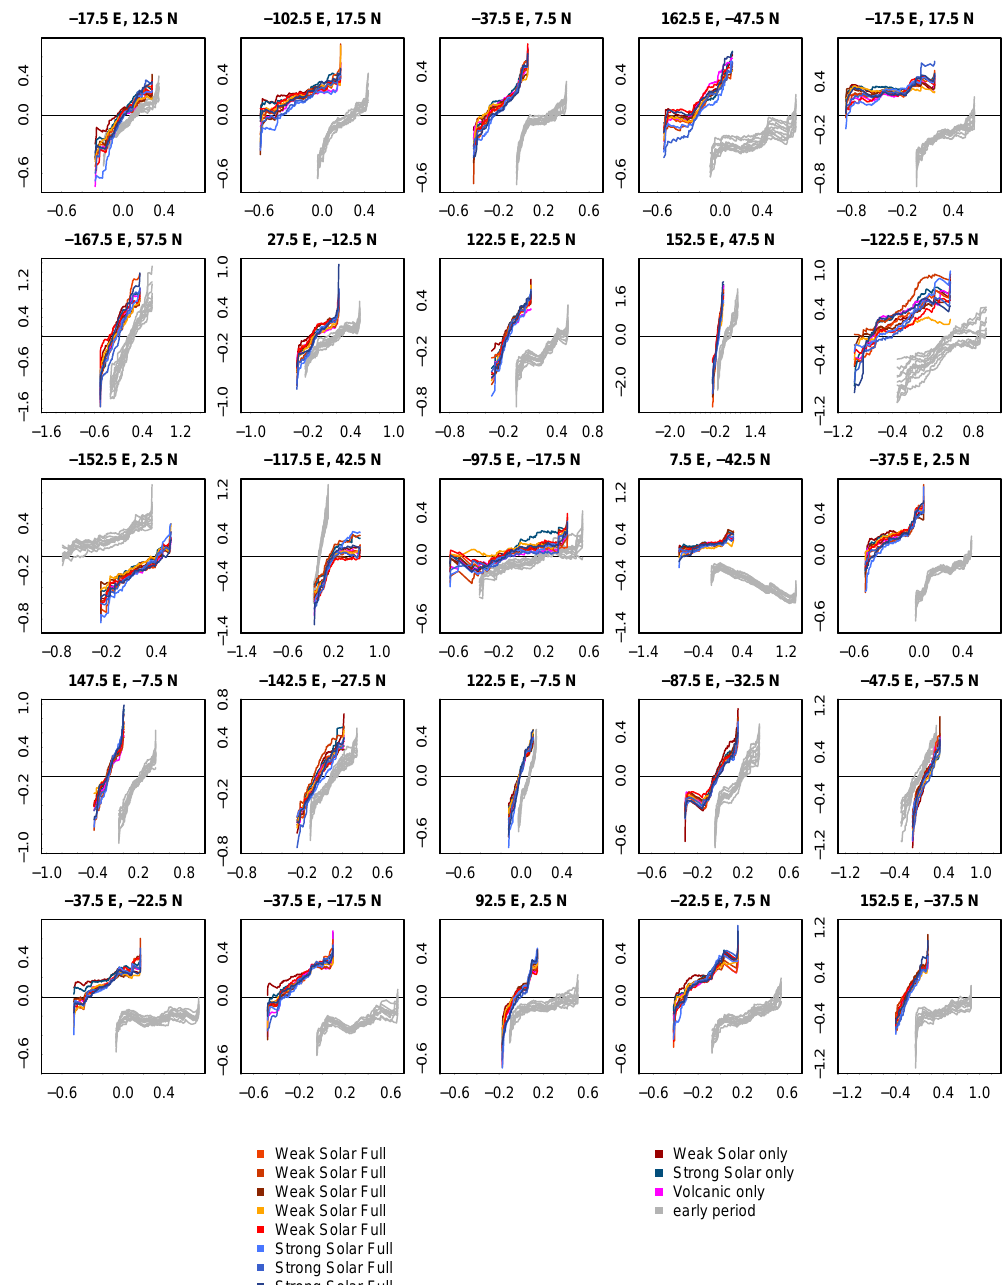
Fig. 9. Residual quantile-quantile plots for a random selection of 25 grid points from the decadal smooth global temperature data and the first (grey) and the last (colours) 250 records. Locations given in titles of individual panels. For representation see legend.